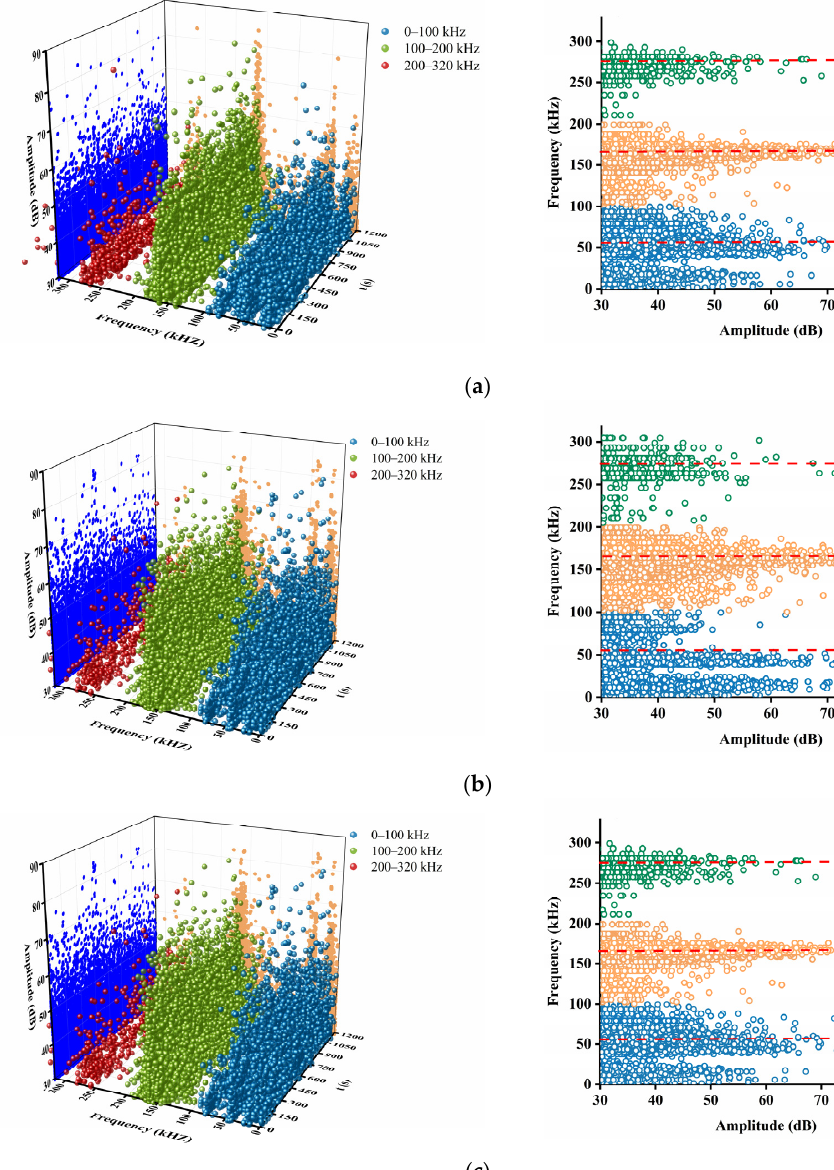
Figure 12. Frequency domain characteristics of the bond interface. ( a ) SRB-1. ( b ) SRG-1. ( c ) SRL-1.